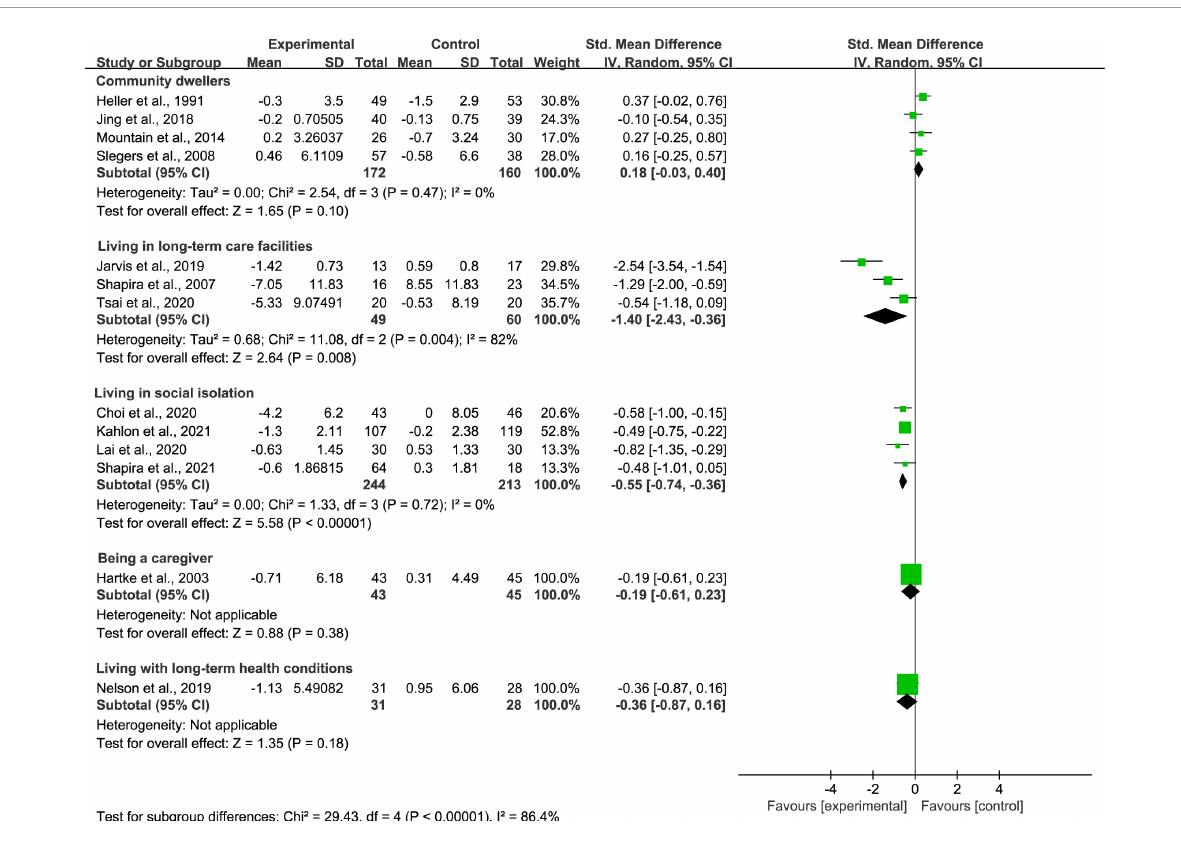
FIGURE6 Subgroup analysis: comparison of old adults as community dwellers, living in long-term care facilities, living in social isolation, being a caregiver or living with long-term health conditions and all controls on the basis of loneliness scores.